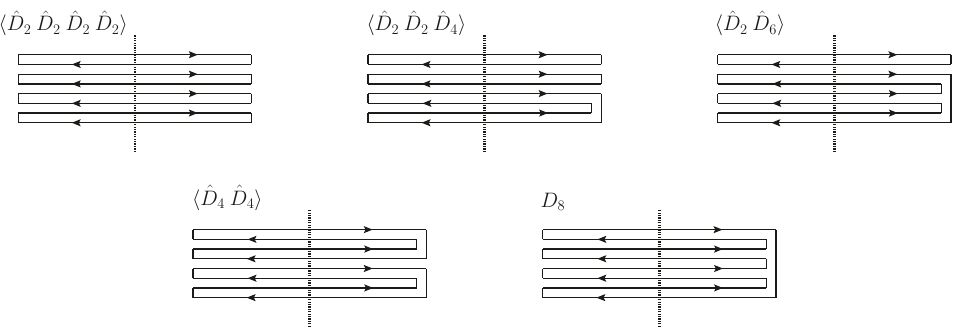
^ D ^ D ^ D ^ D ^ D ^ D ^ D ^ D ^ D ^ D ^ D 2 2 2 2 i , h 2 2 4 i , h 2 6 i , h 4 4 i , and h